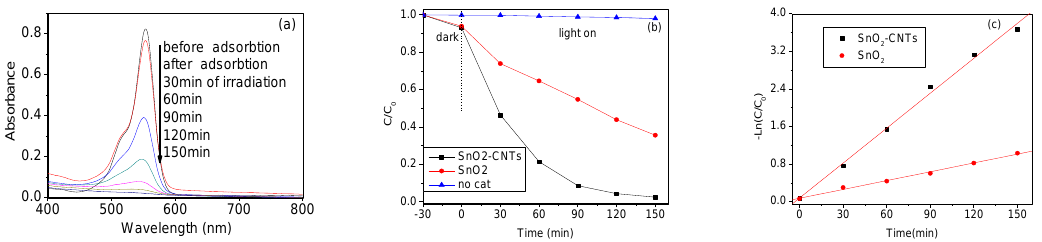
Figure 5. ( a ) The UV-Vis spectrum changes during Rhodamine B (RhB) (10 − 5 M) photodegradation by SnO 2 -CNTs photocatalysts; ( b ) Plots of photocatalytic degradation of RhB concentration vs. irradiation time in the presence of SnO 2 -CNTs samples; ( c ) dependence of − ln( C / C 0 ) on irradiation time.